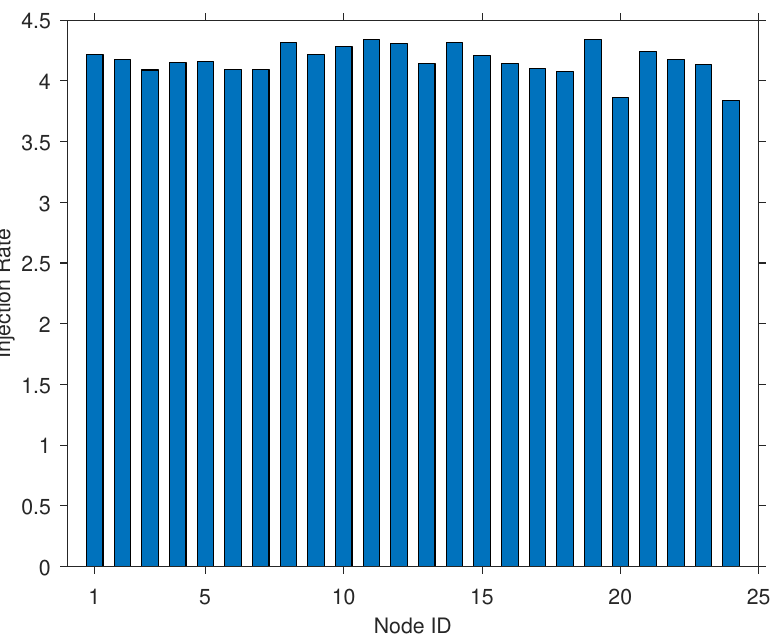
Figure 2. packets injection rates for the randomized injection model (RIM) for a 10 min